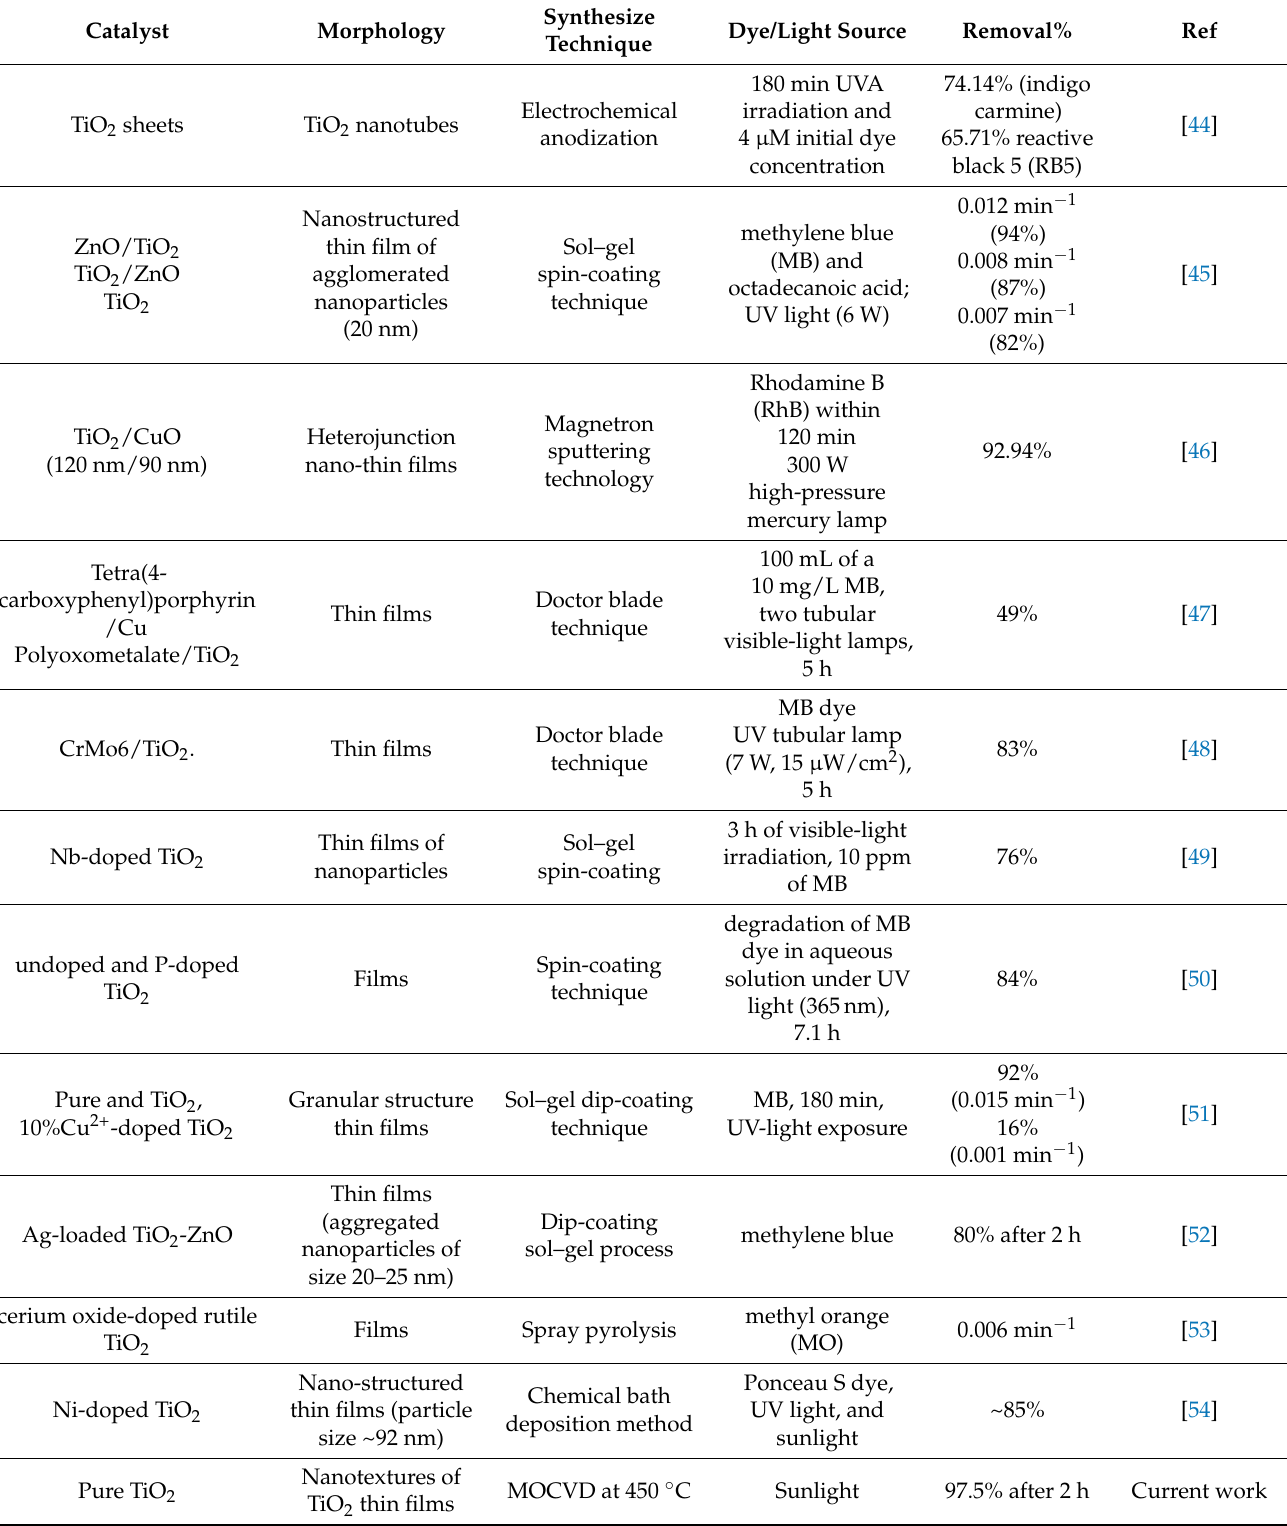
Table 3. Comparison of the photocatalytic performance of our optimized photoelectrode with TiO 2 - based catalytic electrodes of different nanomorphologies applied for dye removal in the